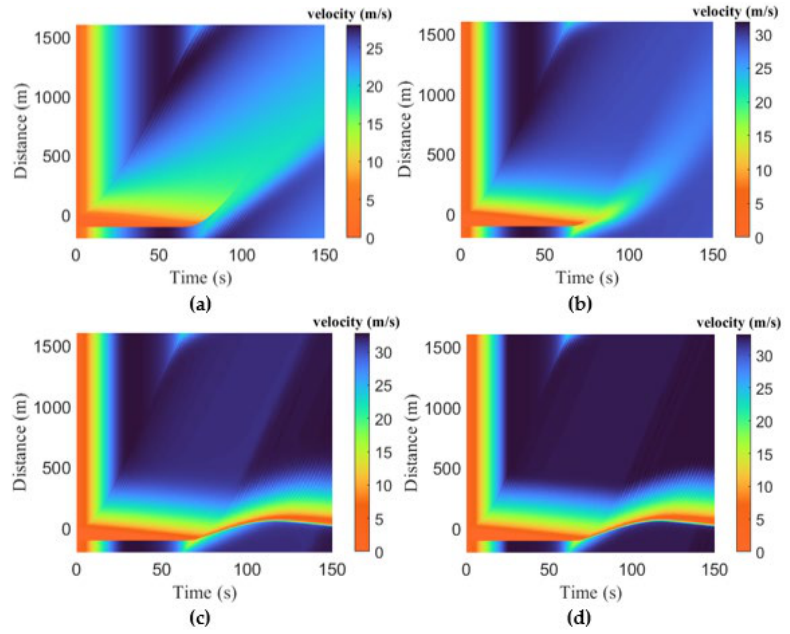
Figure 6. Velocity evolution over time and space for the ID model on an 1800 m circular road: